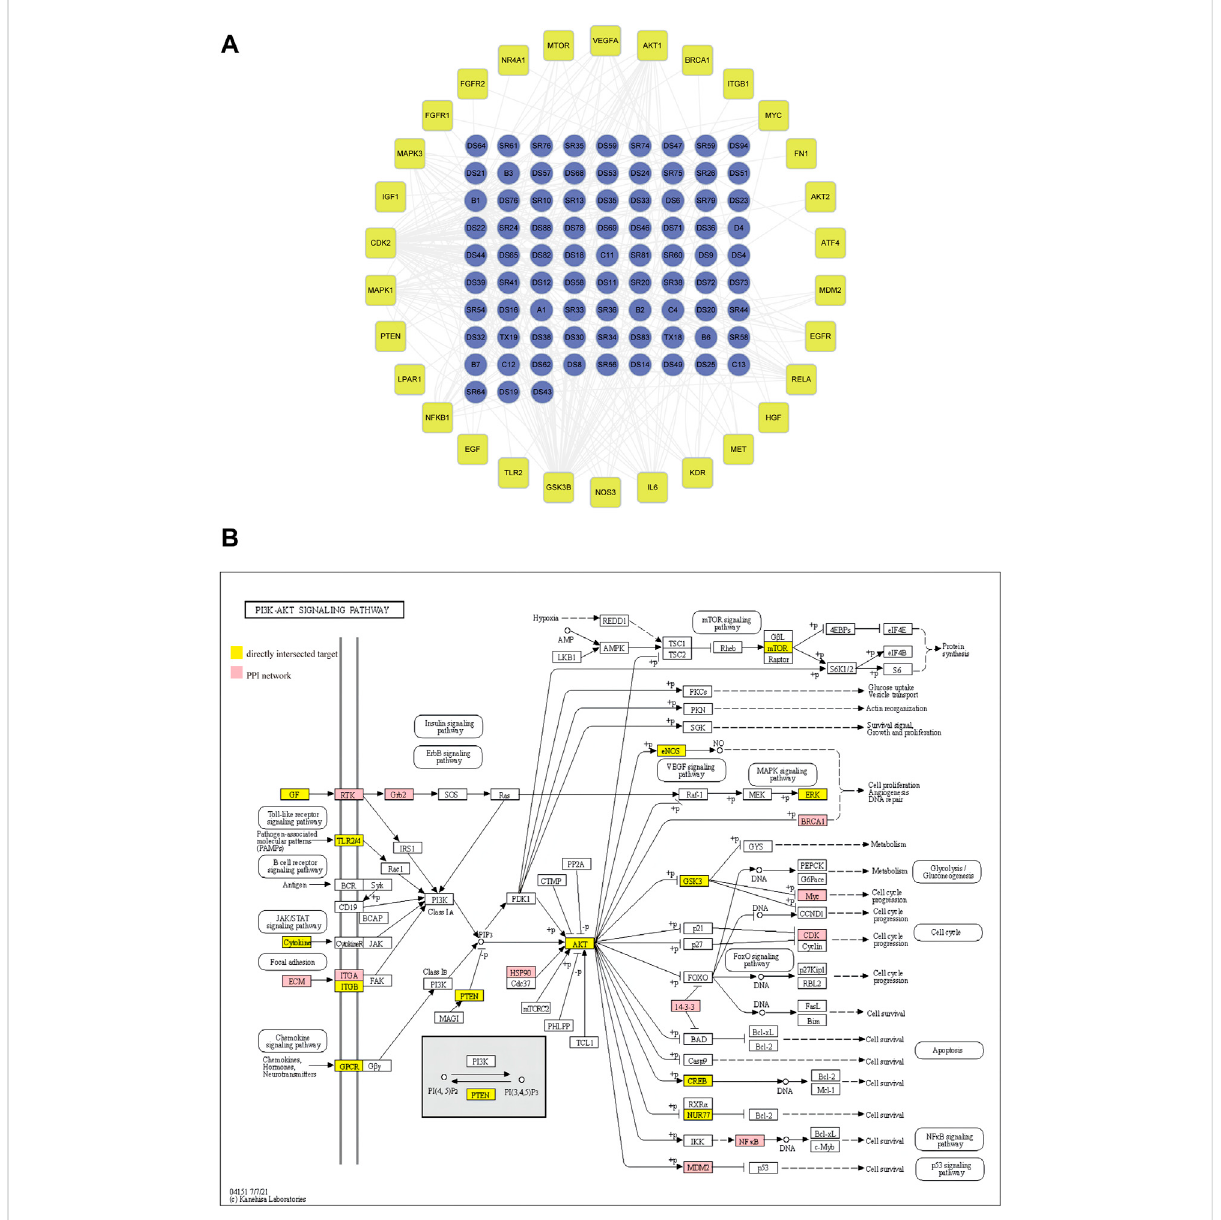
FIGURE 2 Screening of PI3K/AKT signaling pathway for regulation of EndMT in AS. (A) network of bioactive ingredients with PI3K/AKT targets extracted fromdirectlyintersectedandPPIcoretargets. (B) Thespeci fi cpositionandfunctionofPI3K/AKTtargetsinsignalingpathways.Therednodesandthe yellow nodes represent the speci fi c position of targets screened from PPI and from directly intersected targets respectively in the